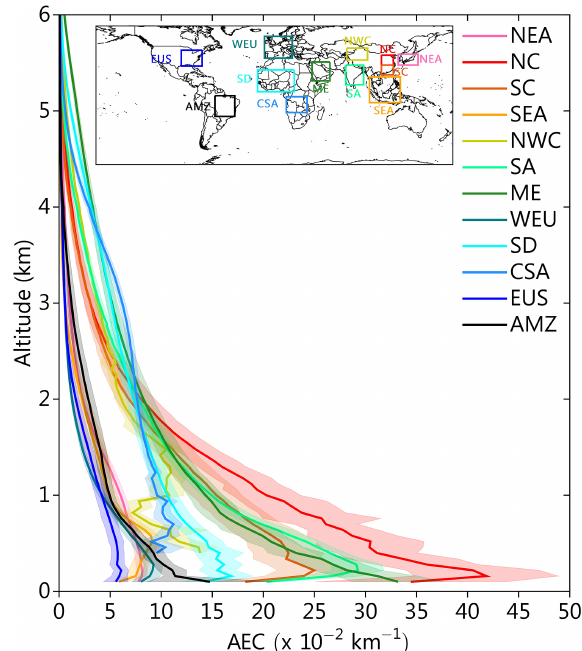
Figure 5. Regional-averaged vertical profiles of multi-year aver- aged AEC for total aerosols over the 12 regions of interest (ROIs). The shading represents the multi-year average standard deviation. The rectangular boxes marked with different colors on the top map represent the boundaries of each ROI (see Table S1 for more infor-